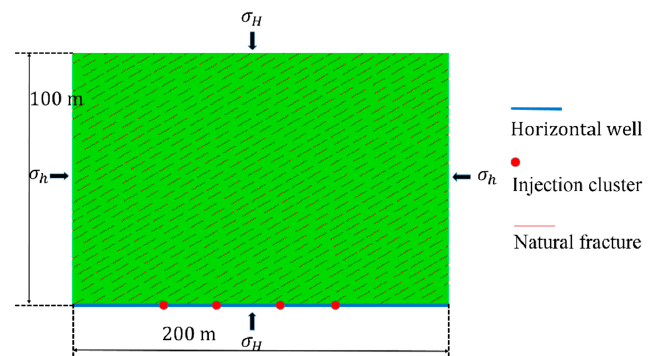
Figure 5. Multiple-cluster model with a 60°approach angle for natural fractures (NFs).